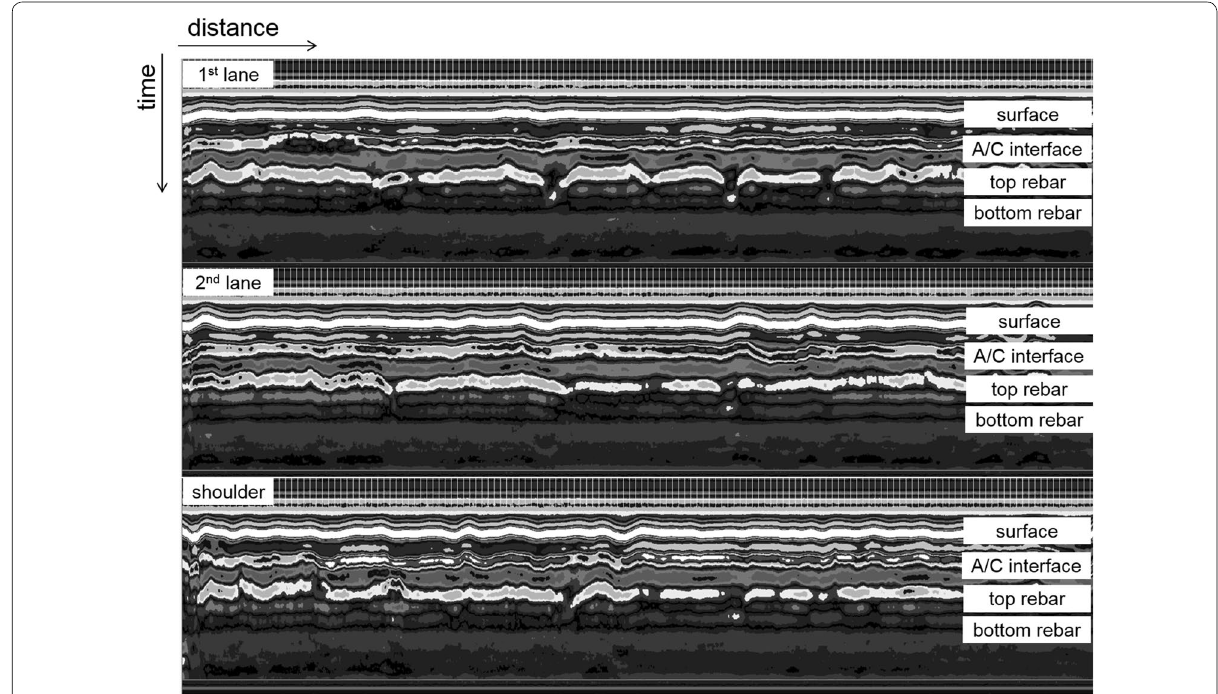
Fig. 9 Typical GPR B‑scan images measured by air‑coupled GPR system on the pilot bridge.